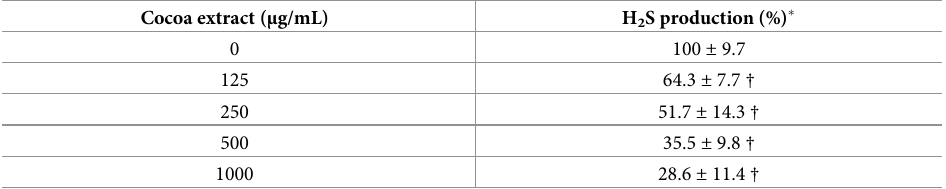
A value of 100% was assigned to H 2 S production by F . nucleatum in the absence of the extract. � : Results are expressed as the means ± SD of triplicate assays from two independent experiments. A value of 100% was assigned to the control (no cocoa extract). †, Significantly different ( p < 0.01) from the control (no cocoa extract).